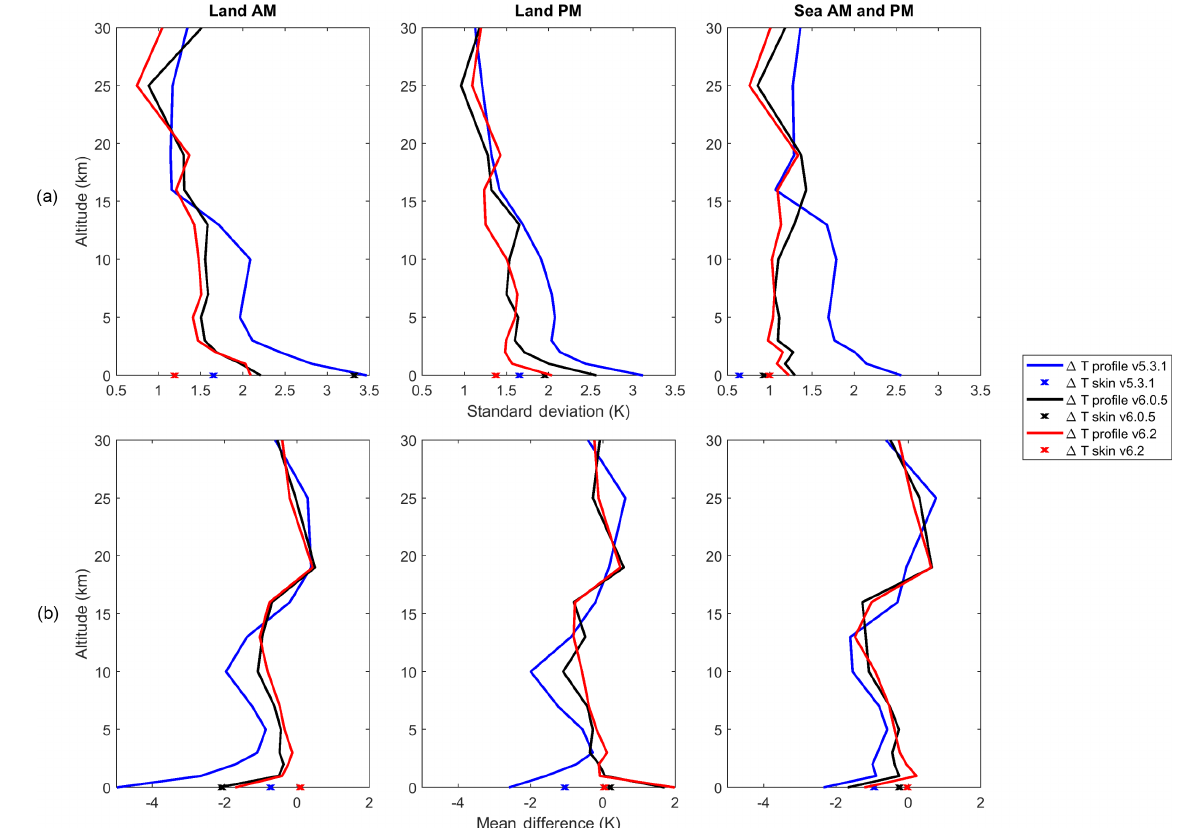
Figure 5. Standard deviations ( a ,K) and mean differences ( b ,K) of air and surface temperatures between IASI L2 v5.3.1 (29 September 2014), v6.0.5 (1 October 2014) and v6.2 (1 October 2016) and the reanalysis for the morning overpass over land (left), the evening overpass over land (middle) and the morning and evening overpasses over sea